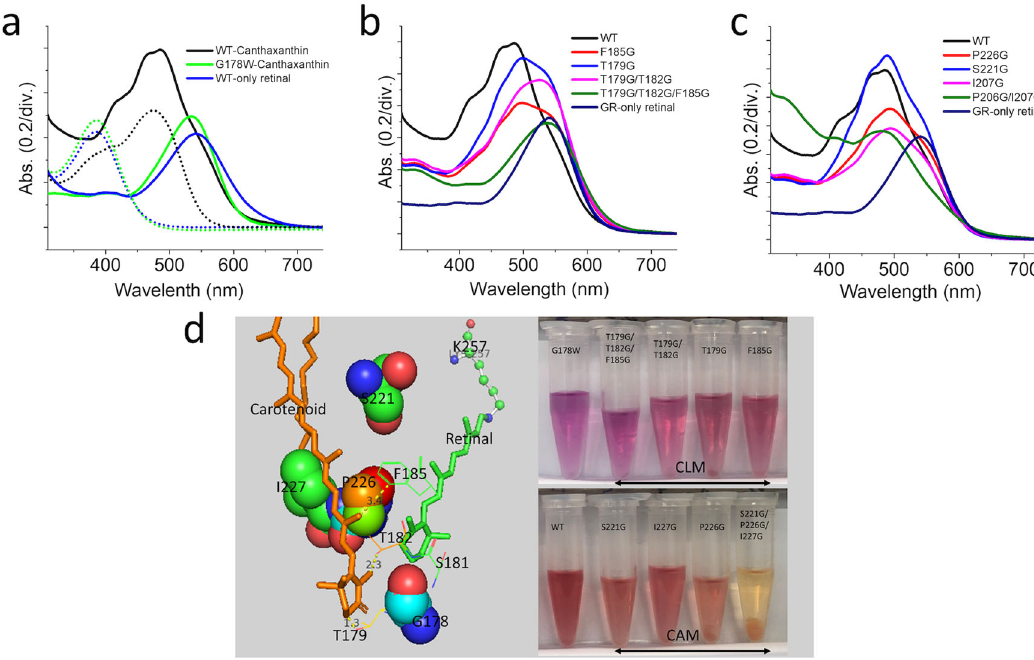
Fig. 1 Co-expression of GR wild-type and mutants with canthaxanthin. a GR wild-type with only retinal (blue line), GR-expressed with both retinal and carotenoid (black line), single mutation G178W expressed with both retinal and carotenoid (green line). Complete chromophore extraction from puri fi ed samples showed blue, black, and green (dot line), respectively. b Absorption spectra of the mutant on helix E near glycine 178, carotenoid locked motif. c Absorption spectra of mutant on helix F, carotenoid aligned motif. d Local view of targeting mutation site, a structure alignment of GR (pdb:6nwd) and XR (pdb:3ddl), and the puri fi ed GR variants co-expressed with